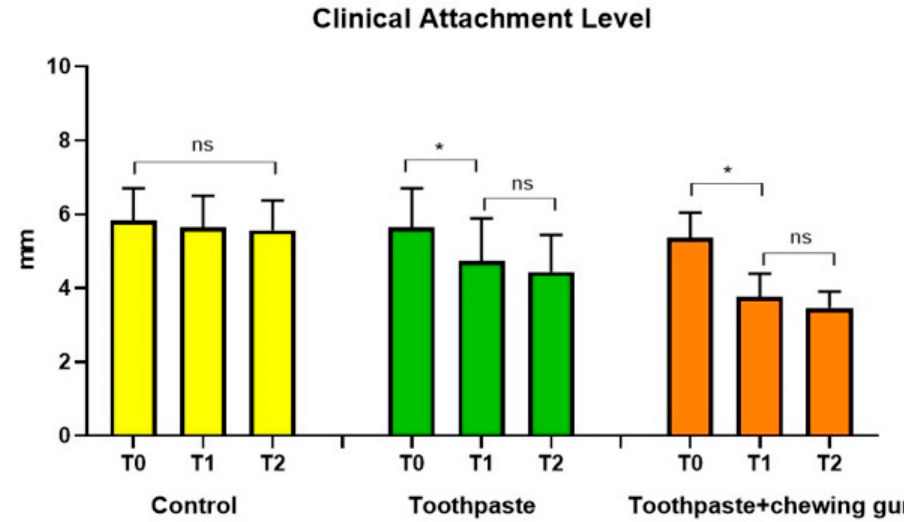
Figure 2. Probing Pocket Depth (mm); Clinical Attachment Level (mm) . *: statistically significant difference ( p < 0.05); ns: not significant difference ( p > 0.05).